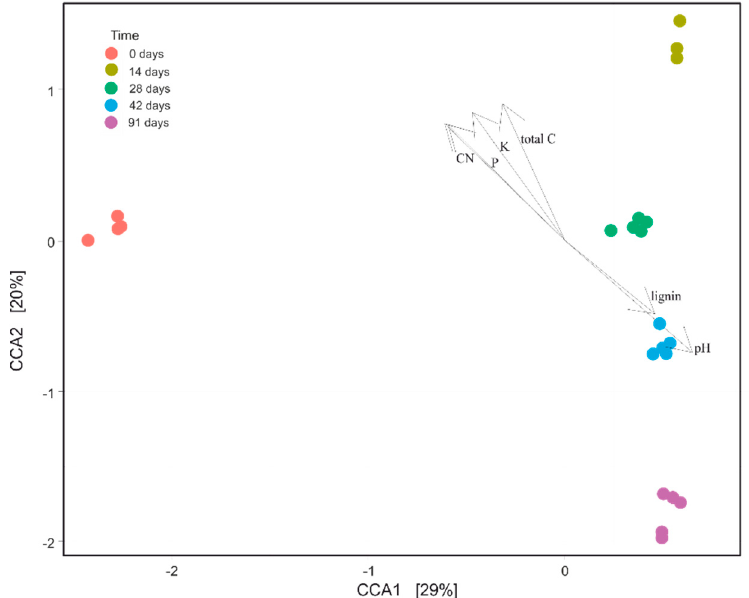
Figure 6. Canonical correspondence analysis showing the selected physico-chemical parameters (represented as vectors) shaping the bacterial community composition during vermicomposting of grape marc derived from the red winemaking process of the grape variety Mencía. Based on permutation tests, all the physico-chemical variables retained in the model were significant ( p < 0.05) in constraining bacterial communities.